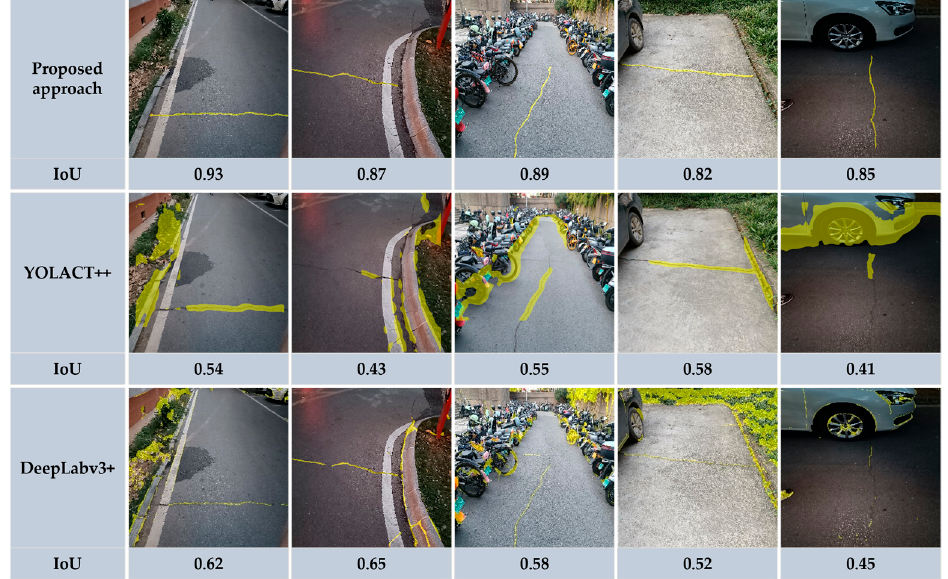
Figure 12. Comparisons of the original and modified Res-UNet to segment cracks from the original images.